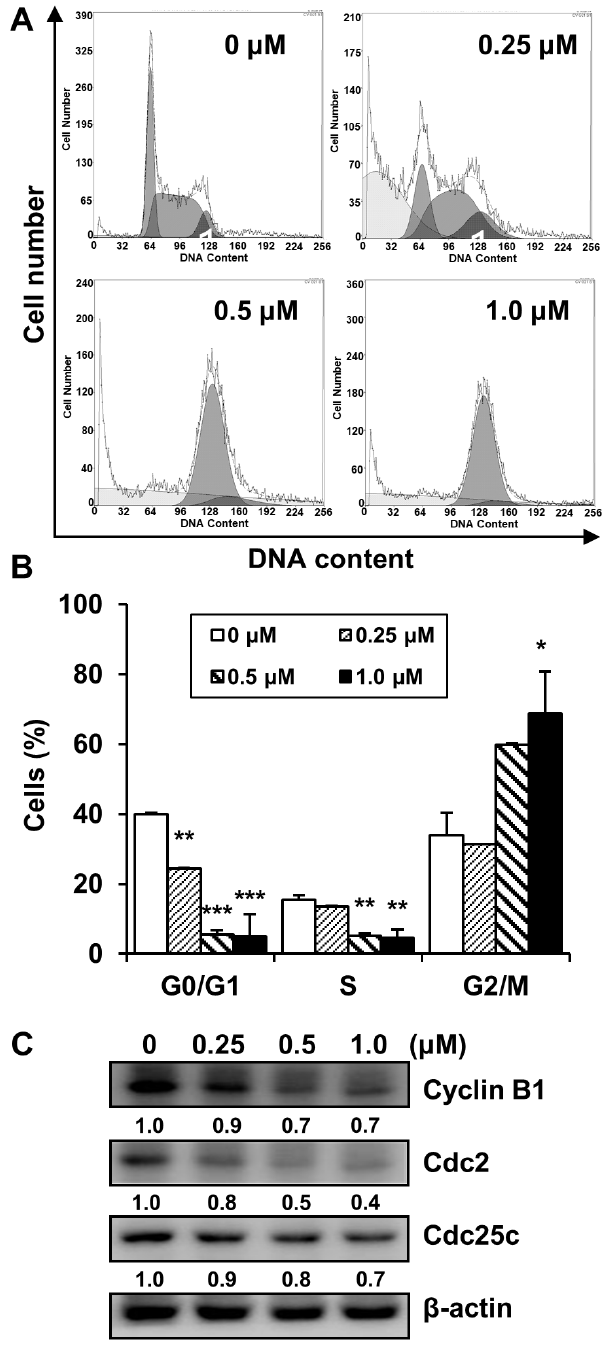
Figure 5. Effect of MHY2245 on cell cycle modulation in HCT116 cells. ( A ) Exponentially growing cells at 60–70% confluence were treated with the indicated concentrations of MHY2245 for 24 h. Propidium iodide (PI)-stained cells were subjected to flow cytometry analysis to determine the cell distribution at each stage of the cell cycle. ( B ) The percentage of cells in the G0/G1, S, and G2/M phases of the cell cycle was calculated and is displayed on each bar graph. Results are presented as mean ± SD, n = 3, and are expressed as a percentage of that in vehicle-treated control cells. * p < 0.05, ** p < 0.01, and *** p < 0.001 compared with vehicle-treated control cells. ( C ) Effects of MHY2245 on the expression of cell cycle regulatory proteins analyzed via Western blot analysis of total lysates of cells treated with increasing concentrations of MHY2245. The membranes were probed with Cyclin B1, Cdc2, and Cdc25c. β -actin was used as a loading control. Representative results from three independent experiments are